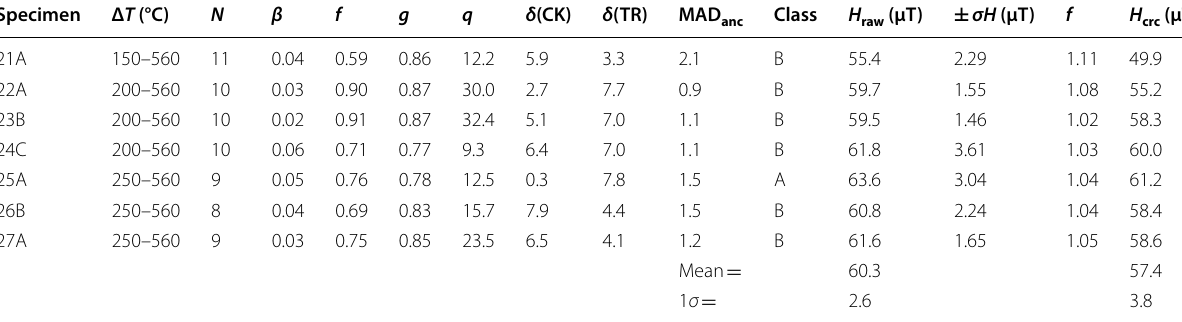
δT temperature interval used for the intensity determination, N number of heating steps used for the intensity determination, β σm standard deviation of m ), f fraction of extrapolated NRM used for intensity determination, g gap factor, q quality factor as defined by Coe et al. (1978), δ (CK), δ (TR), MAD anc and class as defined by Leonhardt et al. (2004), H raw raw archeointensity value, σH standard deviation of H , f cooling rate correction factor, H crc cooling rate‑ corrected archeointensity